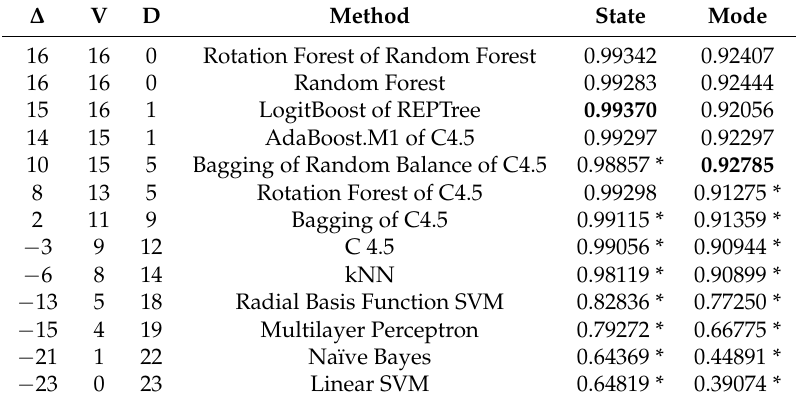
Table 3. Ranking of F-Macro in the classification problems. V is the number of times the method has a better statistically significant F-Macro when compared with the other 12 methods through the 2 predicted variables. D is the number of times the method has a worse statistically significant F-Macro when compared with the other 12 methods through the 2 predicted variables. The ordering criteria ∆ , is equal to V – D. The columns State and Mode have the average F-Macro figures for the method using 10 × 10CV. (*) represents this method has an average F-Macro that is significantly worse than the one for the best-ranked method. The best F-Macros for State and Mode are highlighted in